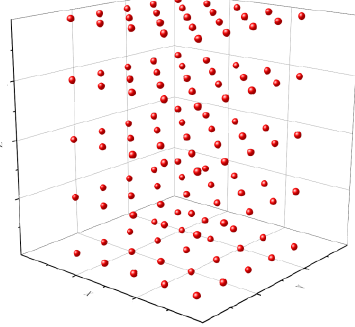
Figure 3. Schematic diagram of measuring point layout.